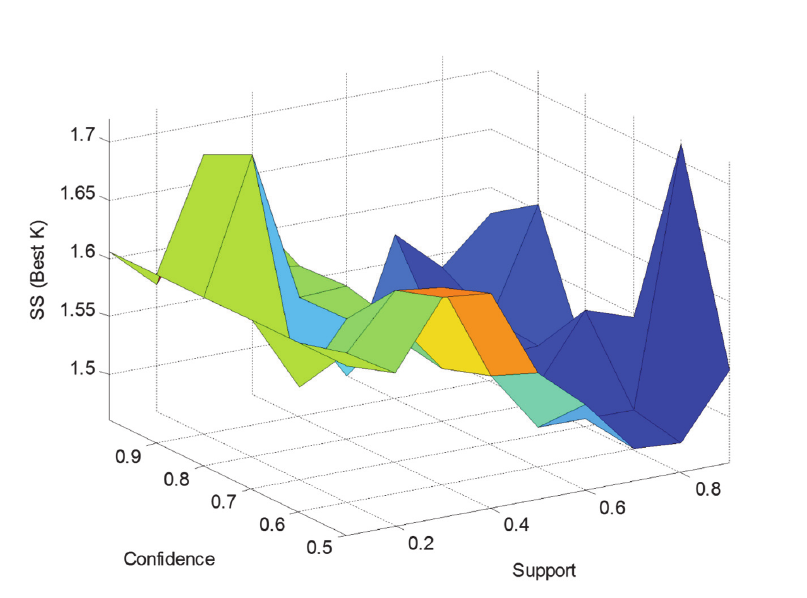
Fig. 6. The quality of clustering for different values of Min-Support and